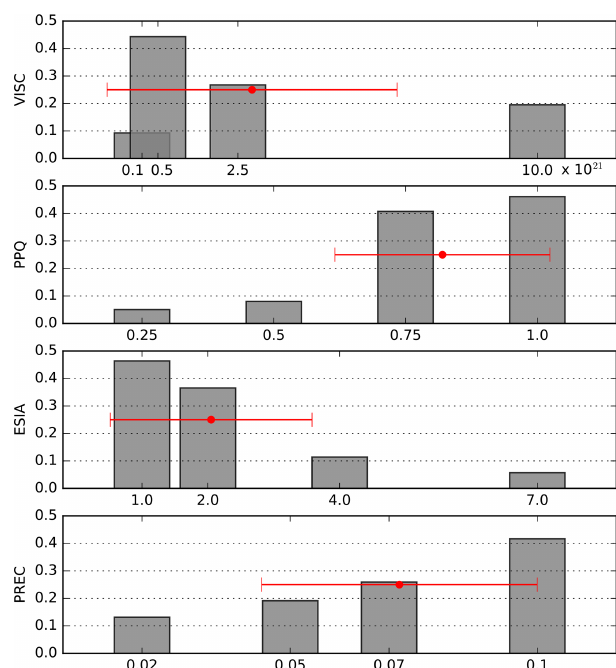
Figure 3. Ensemble-mean scores for individual parameter values (normalized such that sum is 1, or 100%). The weighted mean over the four ensemble-mean scores with standard deviation is shown in red (compare Figs. 3 and C2 in Pollard et al., 2016).